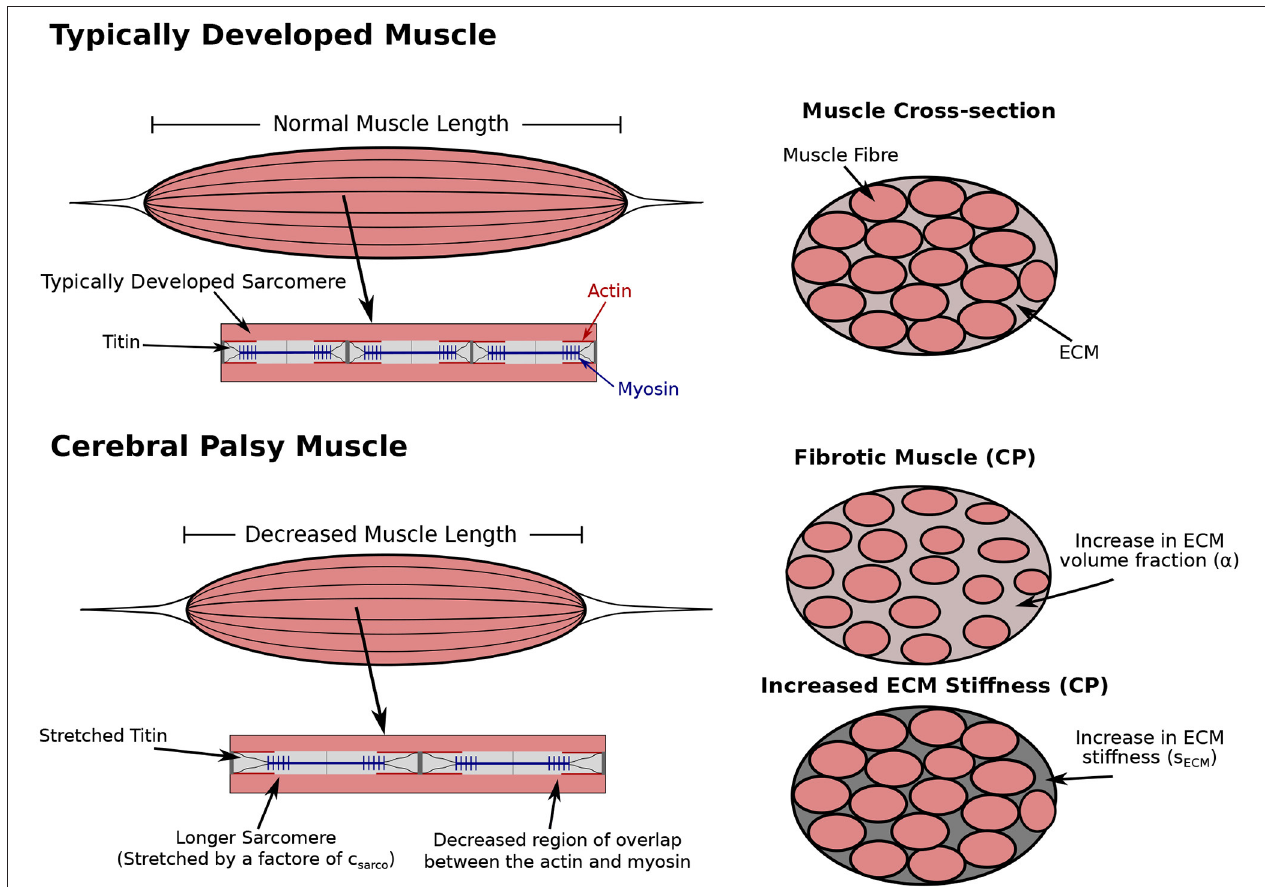
FIGURE 1 | Comparison of typically developed (TD) and cerebral palsy (CP) muscle. CP results in contracture, which is the chronic shortening of muscle, decreasing muscle length relative to TD muscle (not investigated in this study). Longer sarcomere lengths relative to the rest of the muscle have also been observed compared to TD muscle ( Smith et al., 2011; Mathewson et al., 2014b). There is an increase in passive forces due to the increased stretch in the titin proteins. The longer sarcomeres lengths in muscle affected by CP reduces the regions of overlap of the actin and myosin filaments, which results in decreased contractile forces. Additionally, there is an increase in extracellular matrix (ECM) volume fraction, and a possible increase or decrease in ECM stiffness. Any combination of changes to the sarcomere length or ECM properties could occur with